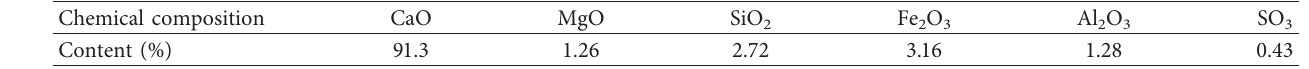
Table 1: Main components of cement.